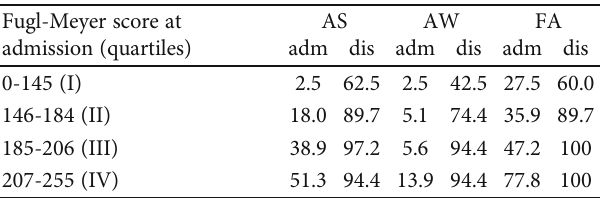
AS: autonomous standing; AW: autonomous walking; FA: functional arm; adm: admission; dis: